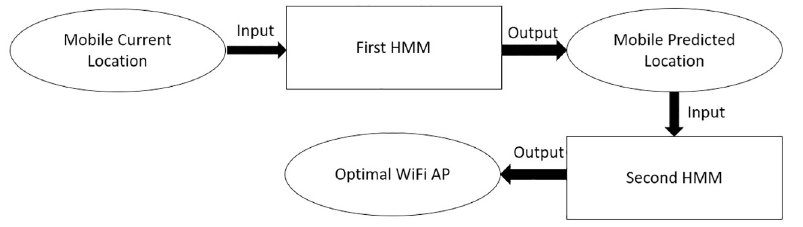
Fig 16. Example of the dual hidden Markov